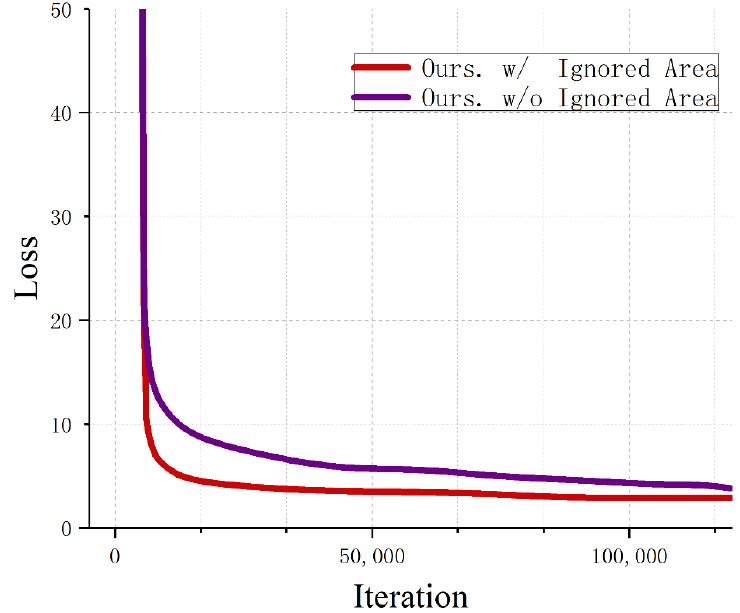
Figure 9. Loss curves of the proposed method with or without the ignored area. The definition of the ignored region in the anchor-free method effectively accelerated the convergence degree of the model.